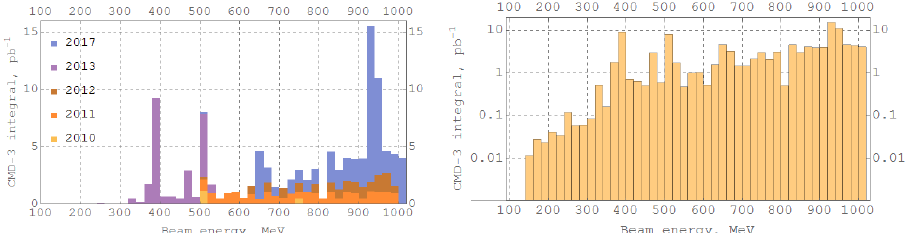
Fig. 5. Total luminosity integral collected by CMD-3 energy